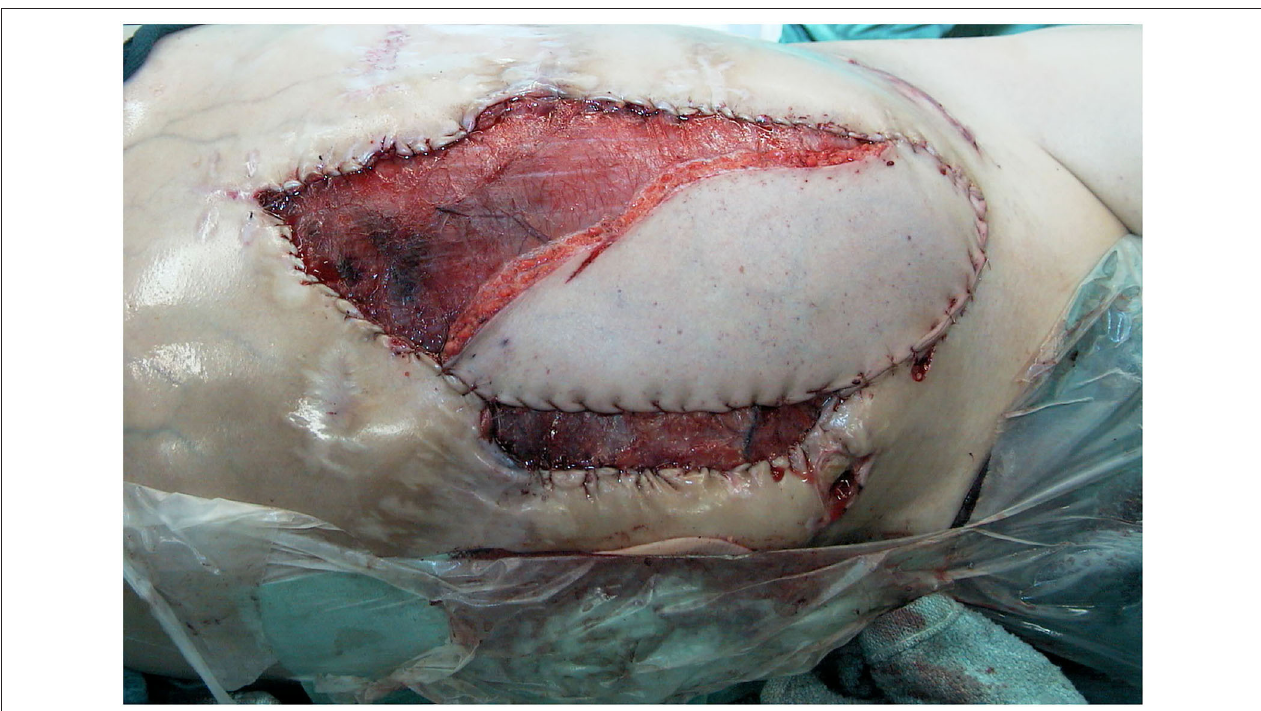
FIGURE 10 | Intraoperative view at the end of insetting of the fLDM flap.